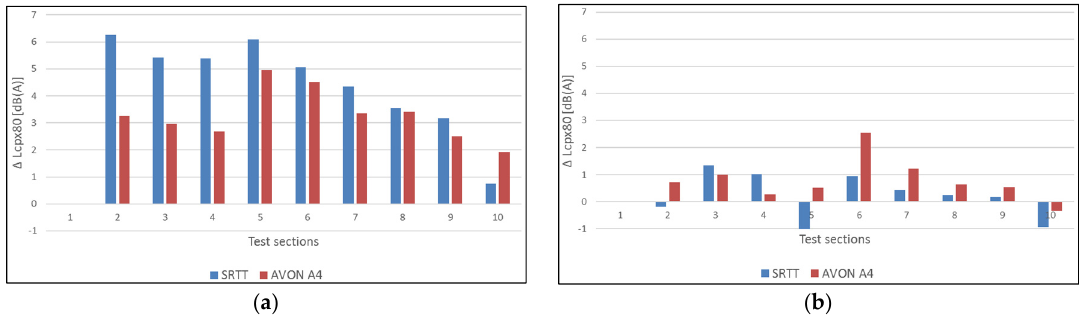
Figure 12. CPX sound pressure level reduction (with temperature correction) of all test sections compared to reference Test Section 1 with the same age, for P1 and H1 tires, ( a ) one month and ( b ) thirty ‐ four months after construction.